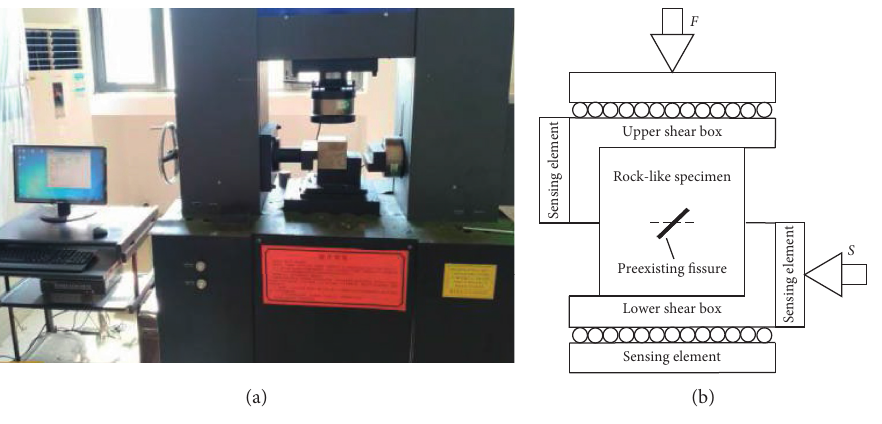
Figure 3: eal biaxial shear loading photo and biaxial loading diagram. Table 1: Comparison of physical and mechanical parameters between original rock and rock-like specimens. Mechanical parameters Sandstone